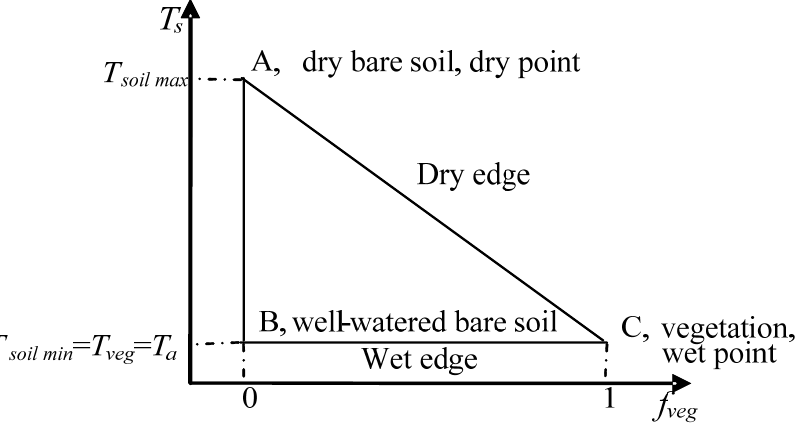
Figure 1. The concept of a triangular VI-Ts diagram. Point A is called a dry point, and Point C is called a wet point in the VI-Ts diagram. AC is named the dry edge, and BC is named the wet